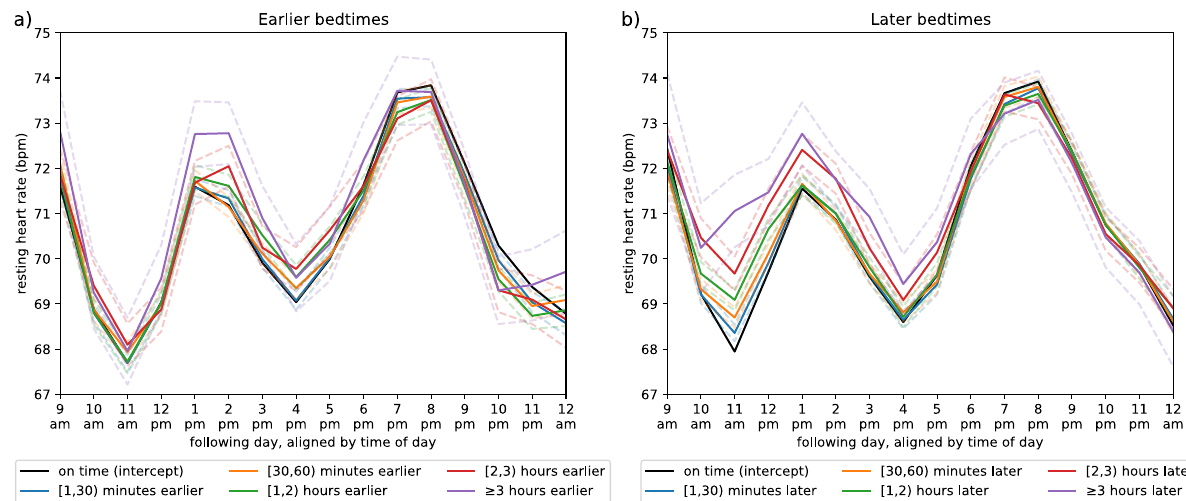
Fig. 2 Resting heart rate across the following day. The panels show the hourly differences in average resting heart rate across the following day strati fi ed by bedtime. a Resting heart rate curves as one goes to bed earlier than normal; b curves as one goes to bed later than normal.